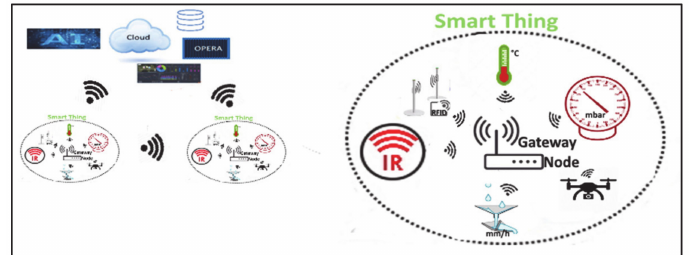
Figure 6. Smart devices with sensing and actuating capabilities and their